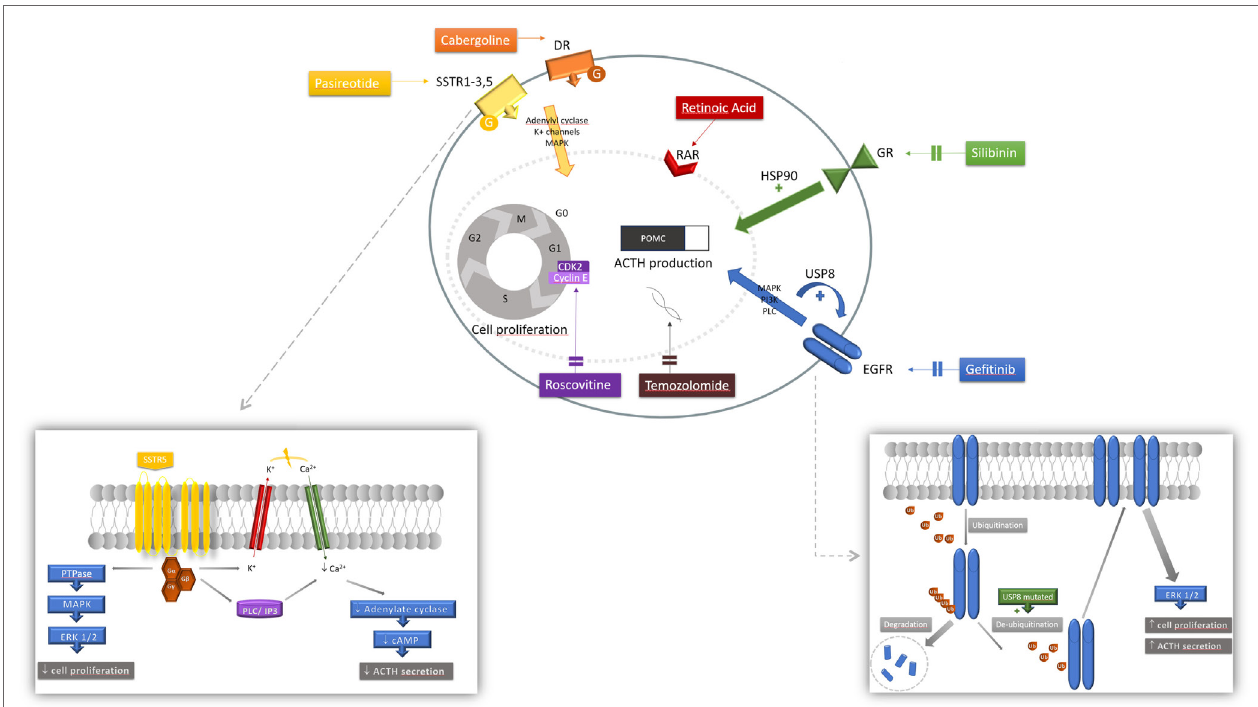
FiGURe 1 | Mechanism of action of pharmacologic therapies. Various mechanisms of action of medications acting at the corticotroph tumor are represented. Each agent involves a different cascade of action resulting in both inhibition of pro-opiomelanocortin (POMC) and adrenocorticotropic hormone (ACTH) synthesis and secretion, and tumoral cell proliferation. Pasireotide is a ligand for somatostatin receptor (SSTR) 1, 2, 3, and 5, activating a G-protein-coupled receptor. Signaling pathways include PTPase and downstream mitogen-activated protein kinase (MAPK) and extracellular signal-regulated kinase 1/2 (ERK 1/2) inhibiting tumorigenesis; and also closure of the potassium (K + ) voltage channel and activation of the phospholipase C (PLC) and inositol triphosphate (IP3) pathway inducing calcium (Ca 2 + ) influx that will decrease cyclic AMP (cAMP) formation and ACTH secretion. Cabergoline is a dopamine receptor (DR) agonist, binding to a G-protein-coupled receptor activating adenylate cyclase, MAPK and K + efflux. Retinoic acid binds to its nuclear receptor [retinoic acid receptor (RAR)] to induce its inhibitory effect. Silibinin induces conformation changes at the glucocorticoid receptor (GR) level by inhibiting heat shock protein 90 (HSP90); net effect is an increase sensitivity to circulating corticosteroids restoring glucocorticoid negative feedback inhibition. Upon ligand binding, epidermal growth factor receptor (EGFR) induces tyrosine kinase activity with downstream MAPK, phosphatidylinositol-3-kinase (PI3K) and PLC signaling pathways. Ubiquitination of the internalized receptor targets the EGFR to be degraded in the lysosome. In ubiquitin-specific protease 8 (USP8)-mutated tumors, the USP8 mutation increases de-ubiquitination thus decreasing EGFR degradation. More EGFR are found at the membrane increasing its stimulatory effect, partly mediated by ERK 1/2 pathway. Gefitinib effectively blocks EGFR to decrease its